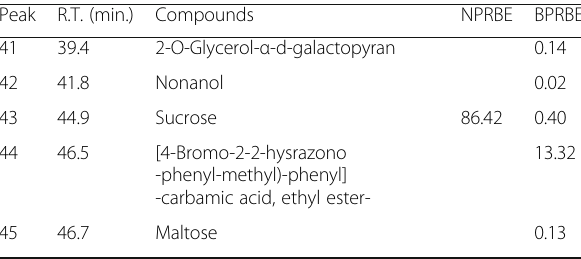
Table 1 Compounds identified by GC/MS analysis of NPRBE and BPRBE (Continued)